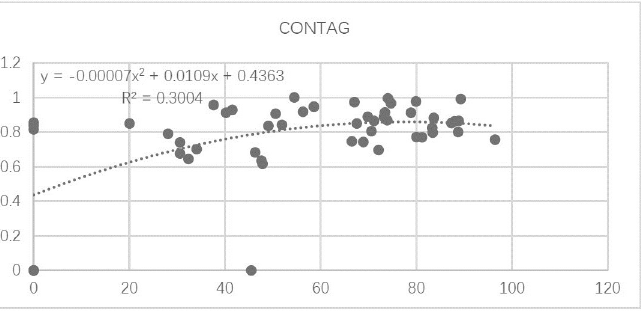
Fig 11. Relationship between the landscape sprawl index (CONTAG) and forest ecosystem service